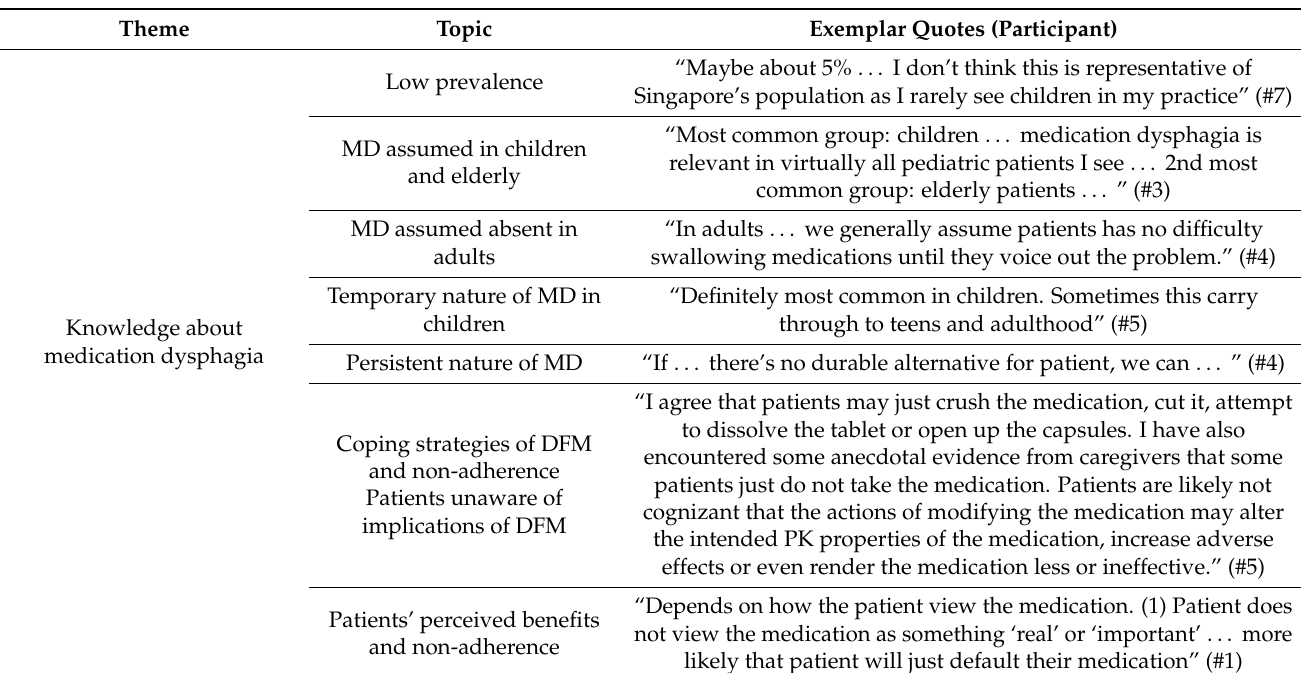
Table 3. Minor theme of management of medication dysphagia, corresponding subthemes, and ex- emplar quotes.